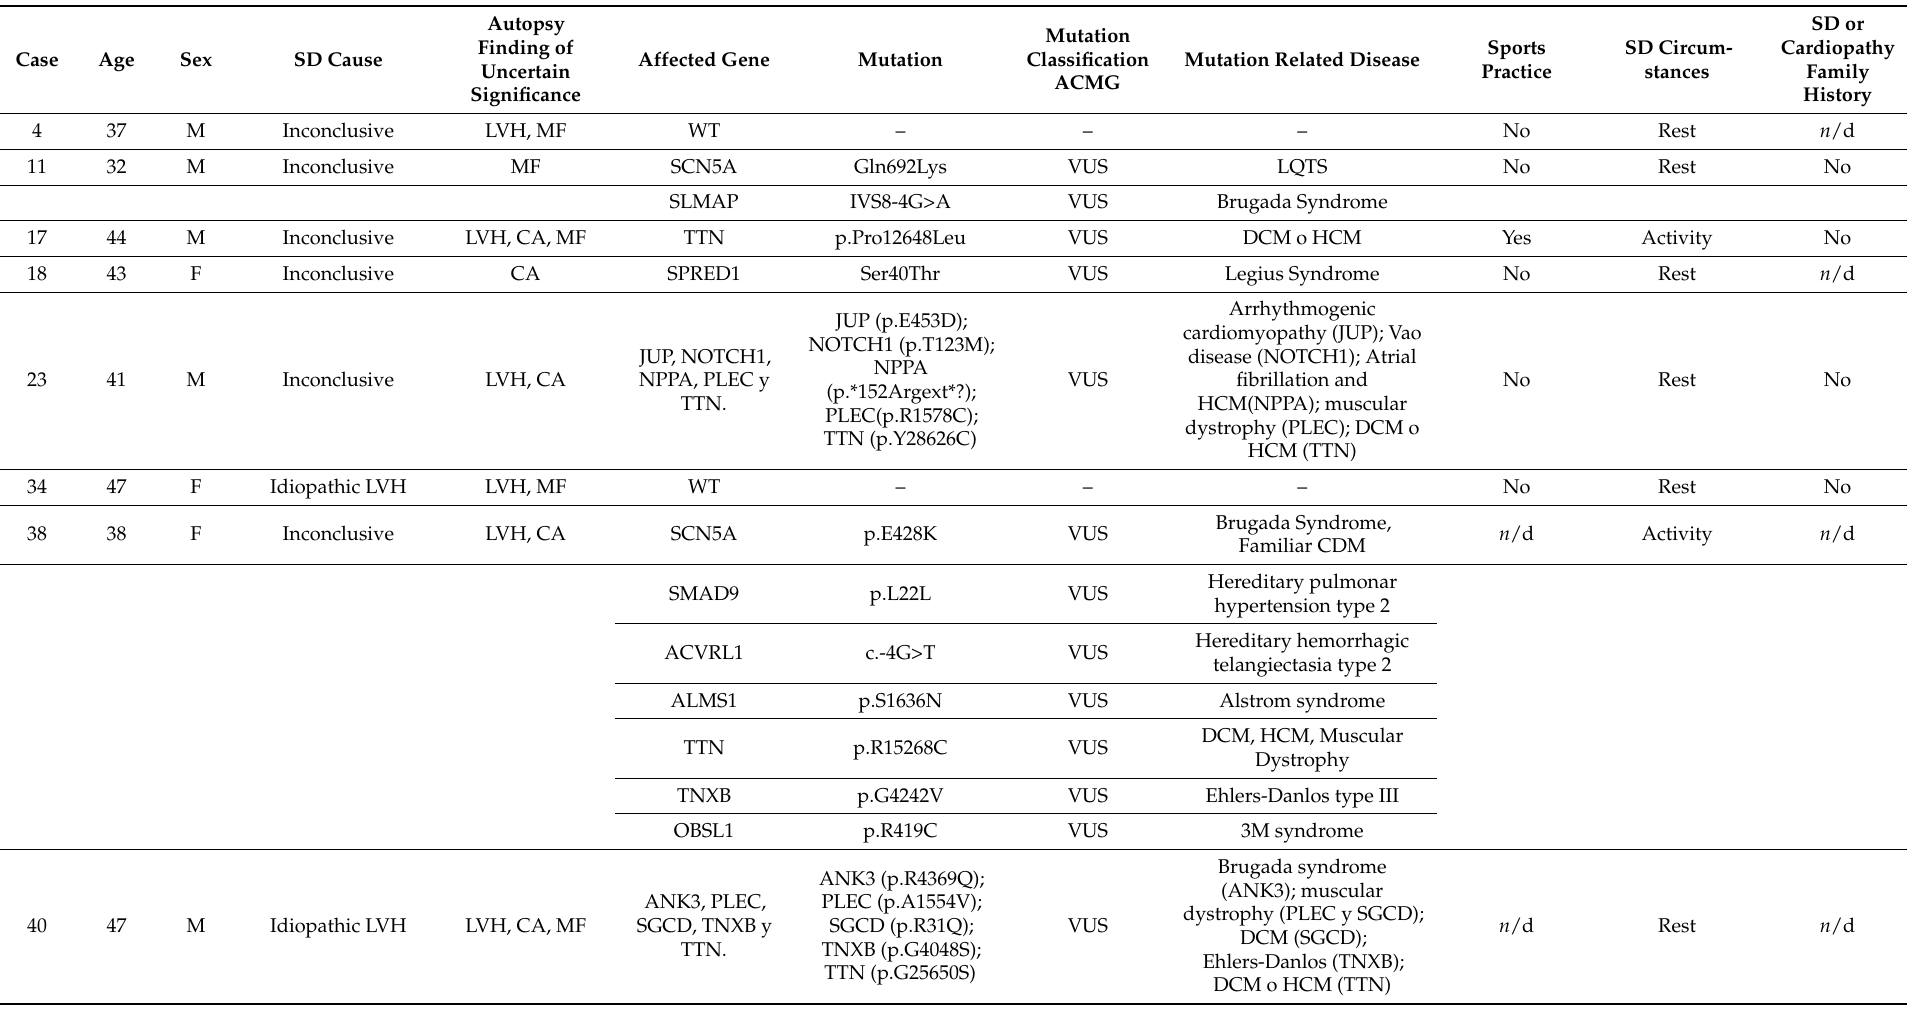
Table 3. Characteristics of Victims of Sudden Cardiac Death with Autopsy Findings of Uncertain Significance. M, male. F, female. LVH, left ventricular hypertrophy. CA, coronary atheroscle- rosis. MF, myocardial fibrosis. WT, wild type. HCM, hypertrophic cardiomyopathy. DCM, dilated cardiomyopathy. LQTS, long QT syndrome. ACM, arrythmogenic